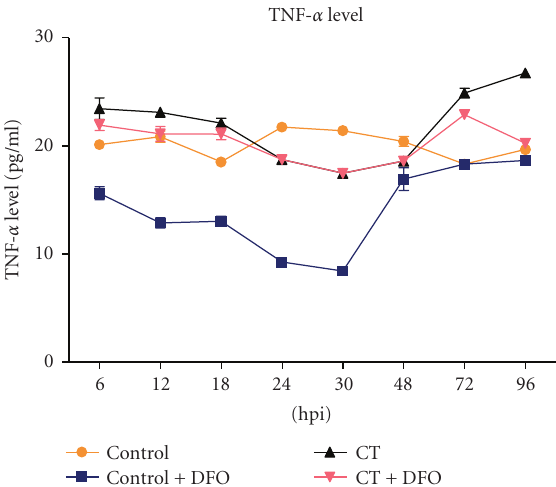
Figure 4: Gradual increase was detected in levels of IL-8 in culture supernatants, highest at 30 hpi; thereafter, subsequent decrease was observed from 48hpi onwords in C. trachomatis infected cells treated with Mimosine. DFO treated cells showed delayed secretion (12hpi) but consistently elevated levels were detected at all the time point